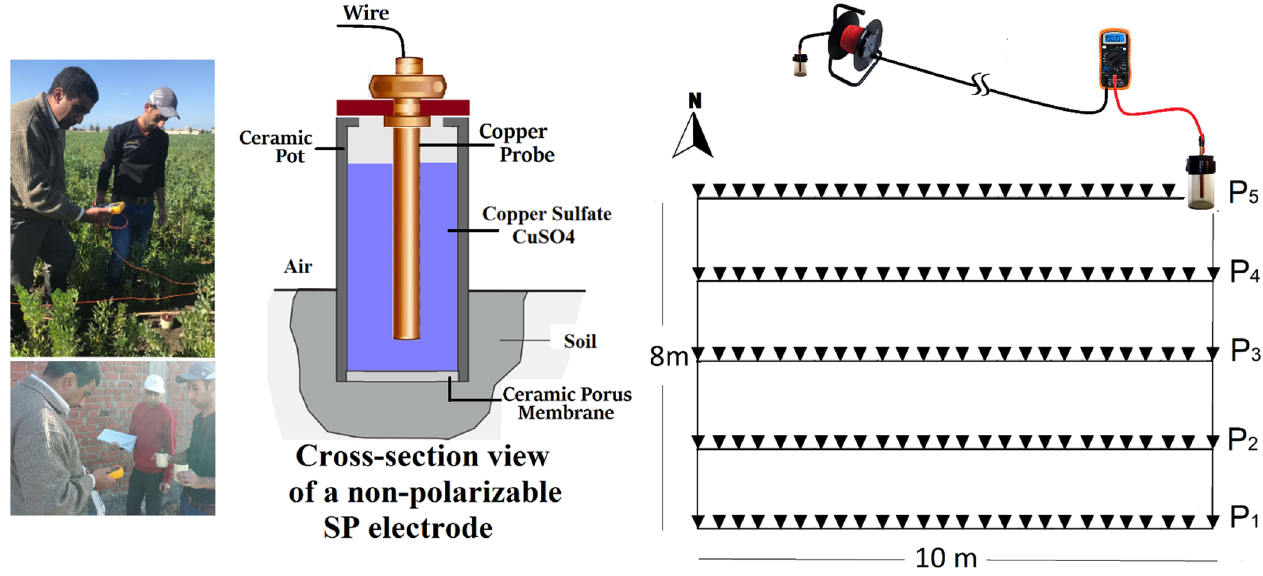
Figure 4. Placing the roving non-polarizable electrode in small well-watered holes to ensure efficient contact with the soil and layout of the grid used to conduct the SP survey using a fixed-based configuration.